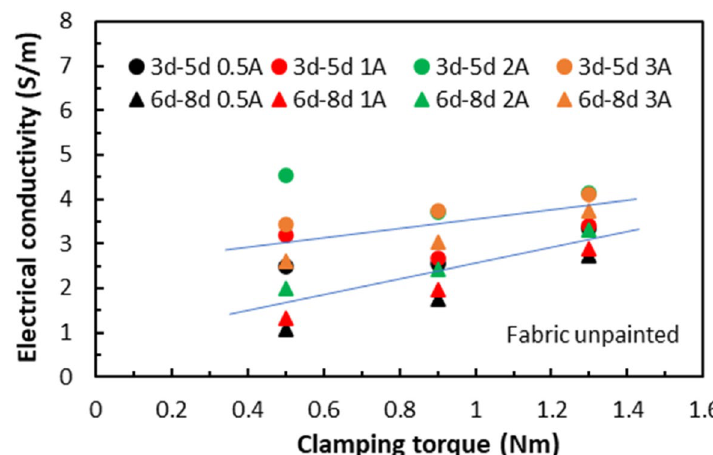
Fig. 18 Effect of clamping torque on TTT electrical conductivity for unpainted carbon/epoxy laminates